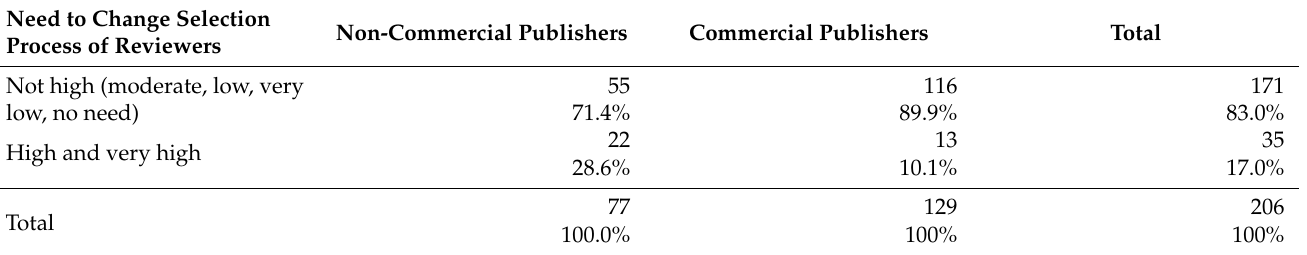
Table 6. Association between publisher’s commercial orientation and respondent’s estimation of need to change reviewer selection